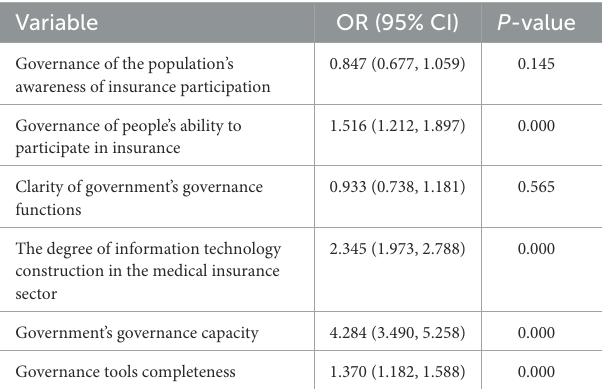
TABLE 3 The logistic regression analysis of factors influencing the effectiveness of governance for full population coverage of medical insurance ( n = 1,975).